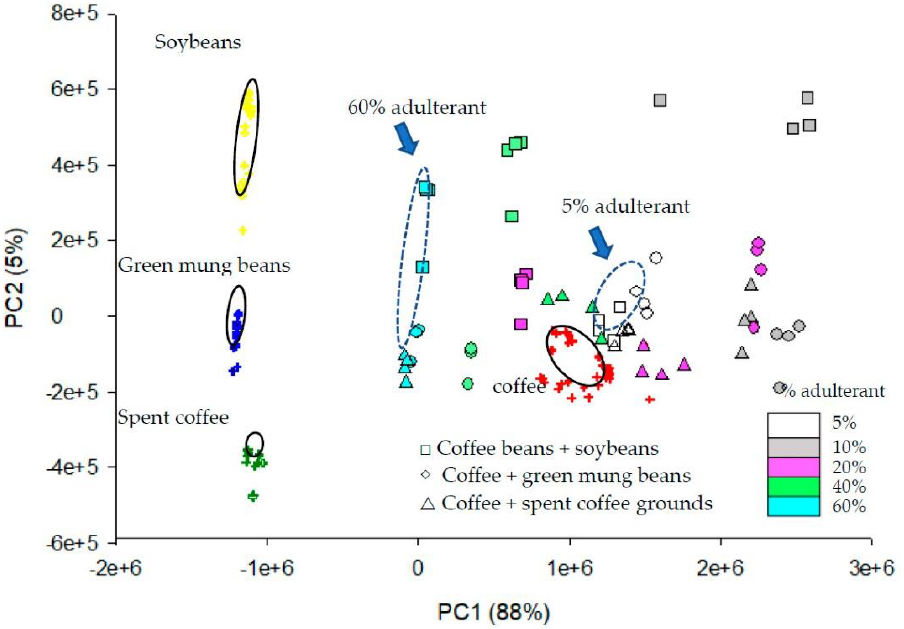
Figure 2. Distinguishing coffee beans from soybeans, green mung beans, spent coffee grounds and adulterated coffee containing different adulterants in different mixing ratios (5%, 10%, 20%, 40%, and 60%) using PCA [123].